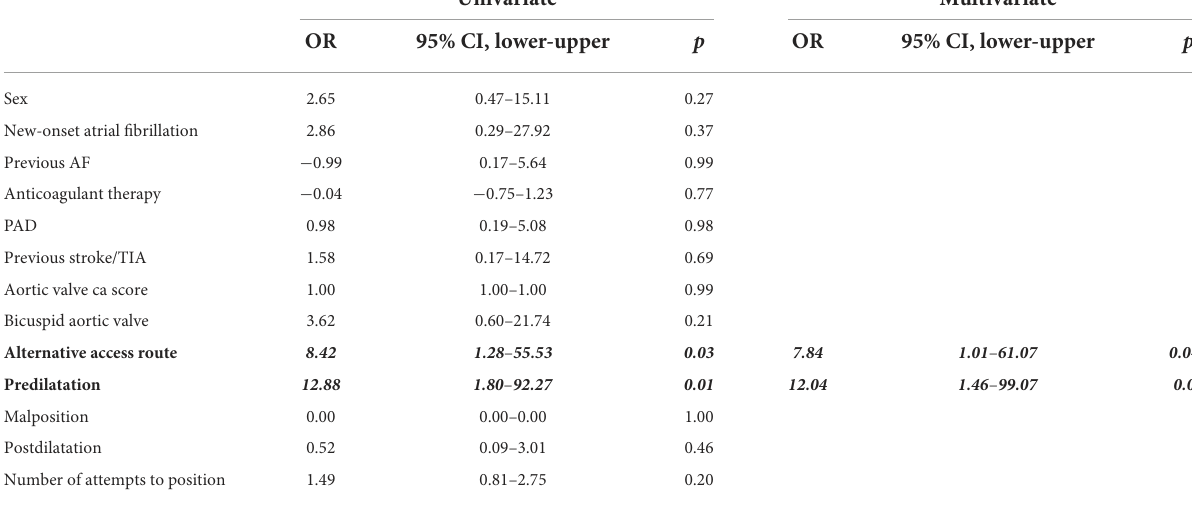
TABLE 5 Multivariate logistic regression analysis of the predictors of periprocedural stroke. Univariate Multivariate